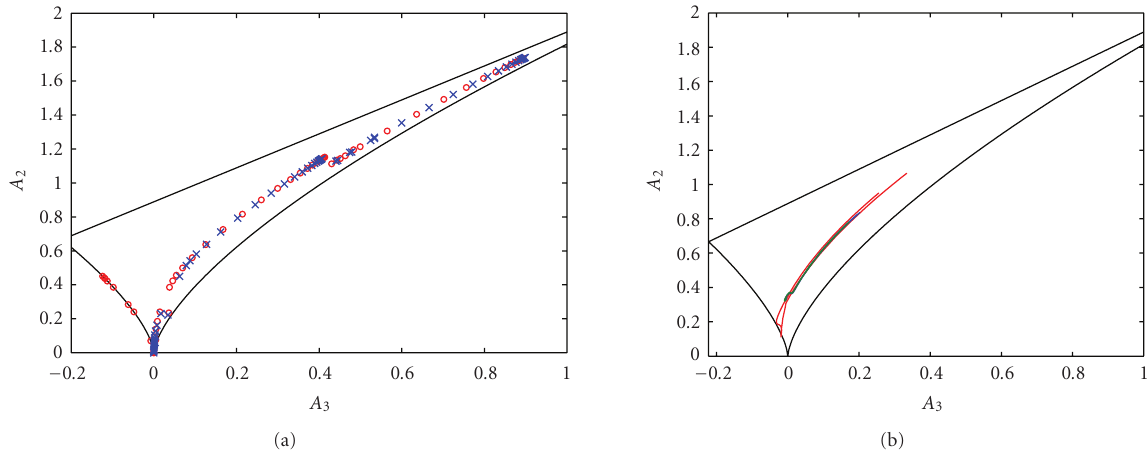
Figure 14: Anisotropy invariant maps at r ∗ = 0 . 7. (a) Influence of the aspect ratio for Re = 1 . 8 × 10 5 and G = 0 . 05 (red), G = 0 . 02 (blue); (b) influence of the Reynolds number for G = 0 . 02 and Re = 5 × 10 5 (red), Re = 3 × 10 6 (blue), and Re = 10 7